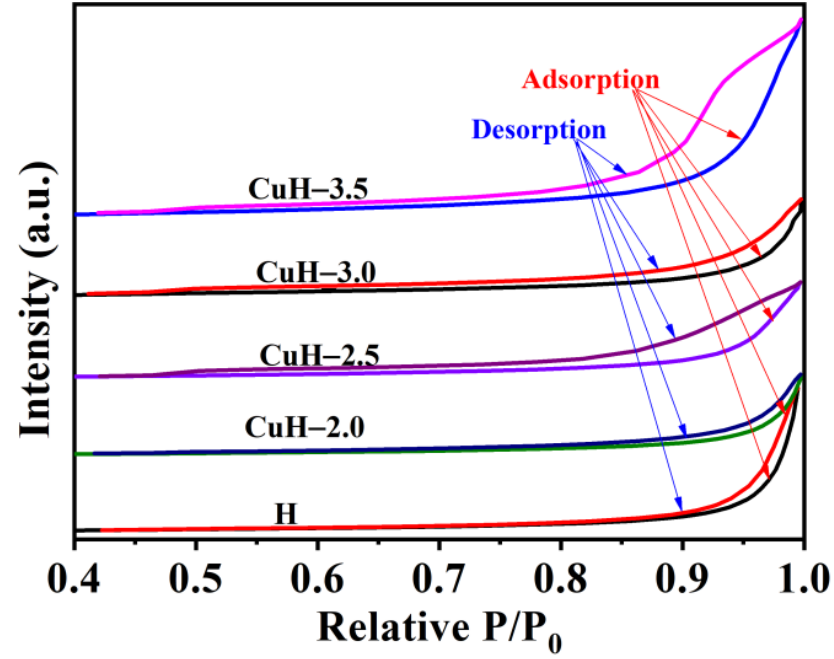
Figure 6. N 2 adsorption/desorption isotherms of five hydrotalcite samples. Table 1. Specific surface area (BET), capillary diameter, and volume capillaries of five composites.